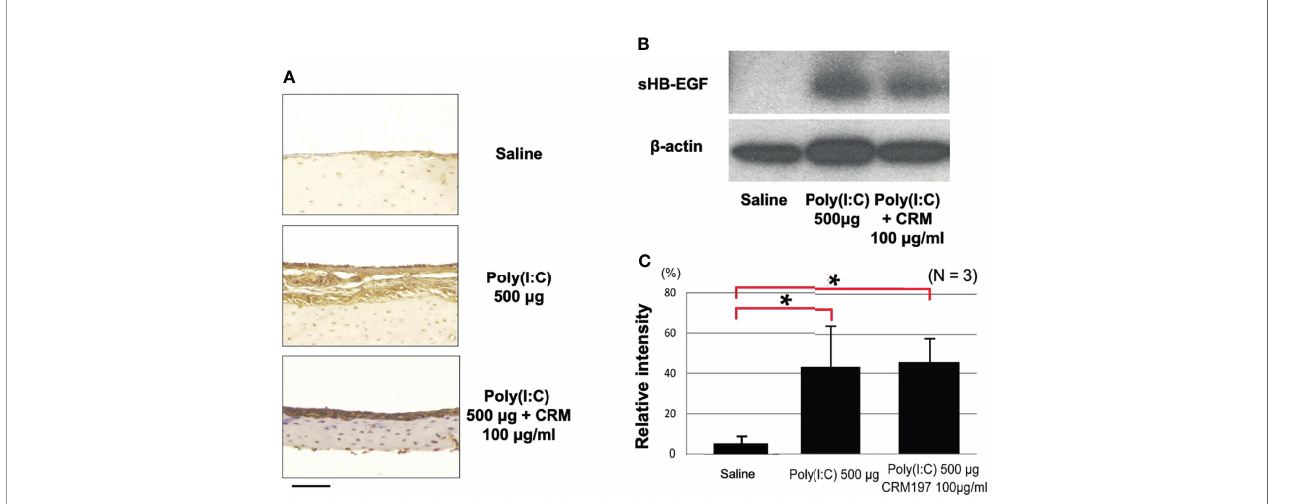
FIGURE 5 | CRM197 does not inhibit HB-EGF expression or processing. (A) Representative microphotographs of immunostaining with a pan anti-HB-EGF antibody are shown. HB-EGF was expressed in rat ME mucosa in all 3 groups on day 2. (B) Representative Western blot sHB-EGF bands for rat ME, 2 days after saline injection or Poly(I:C) administration with or without CRM197. (C) Quantitative analysis showed that sHB-EGF was low in the saline samples but was increased by both Poly(I:C) and Poly(I:C) plus CRM197. N refers to number of samples. *p <